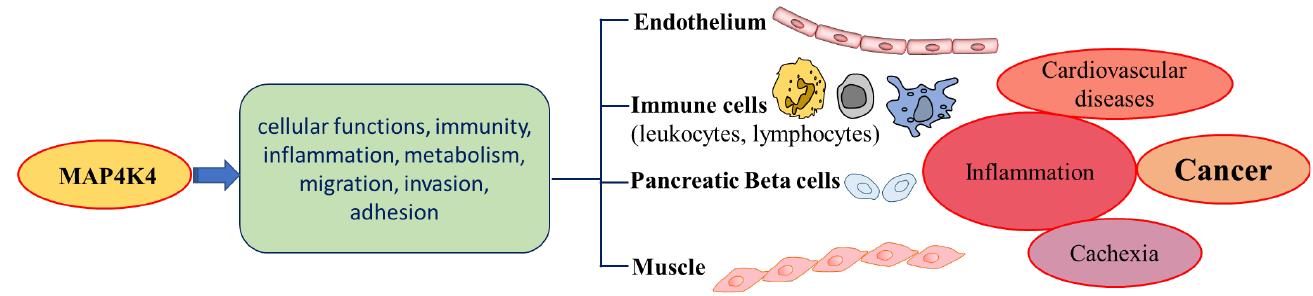
Figure 3. Involvement of MAP4K4 in a variety of regulatory pathways. Effects of MAP4K4 in various metabolic processes involving leukocytes, pancreatic beta cells, and muscles lead to different can- cers.